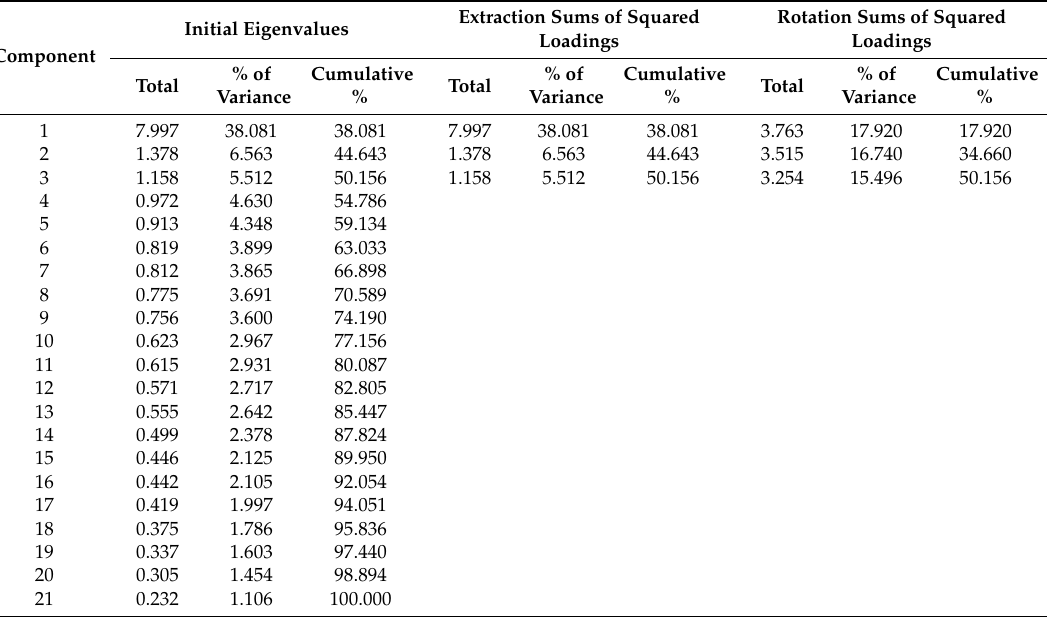
Table 7. Component transformation matrix on the CSF for e-Procurement